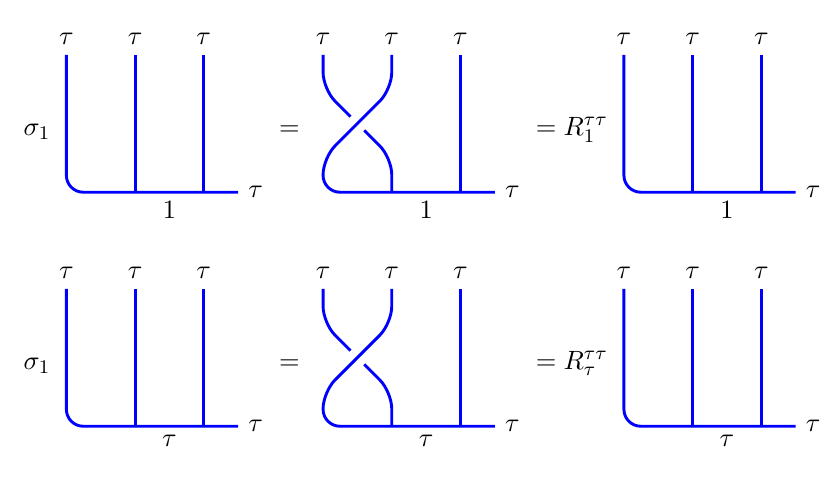
Figure 12 . Construction of σ 1 , a generator of B 3 . Here R ττ